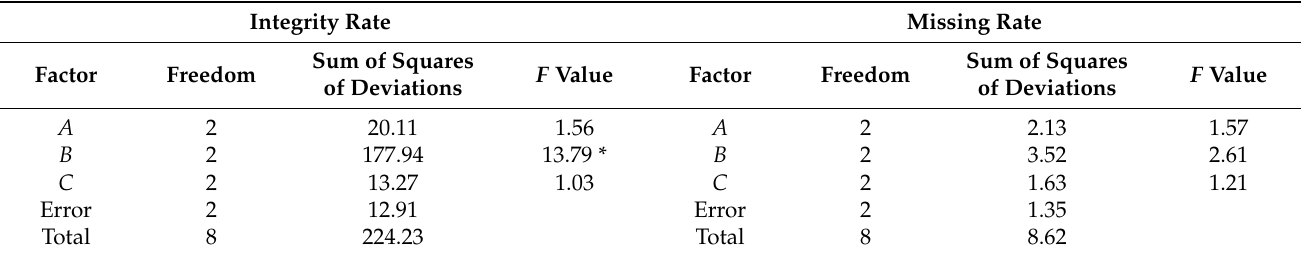
Table 7. Variance analysis for integrity rate and missing rate of tea